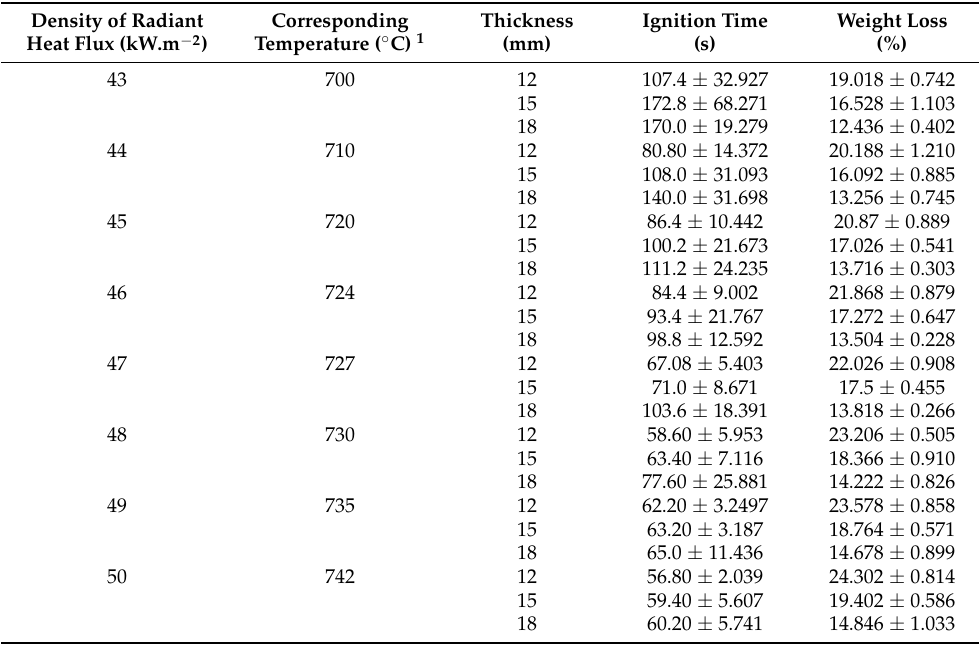
Table 2. Ignition time and weight loss in samples with different thicknesses using heat fluxes of 40 to 50 kW.m − 2 at a distance of 20